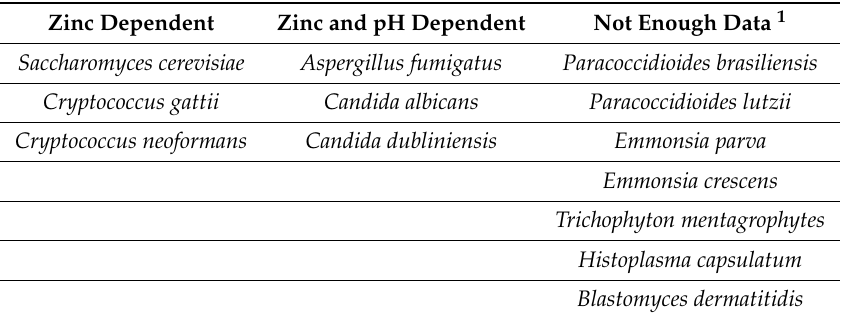
Table 1. Pathogenic fungal species with published studies on zinc